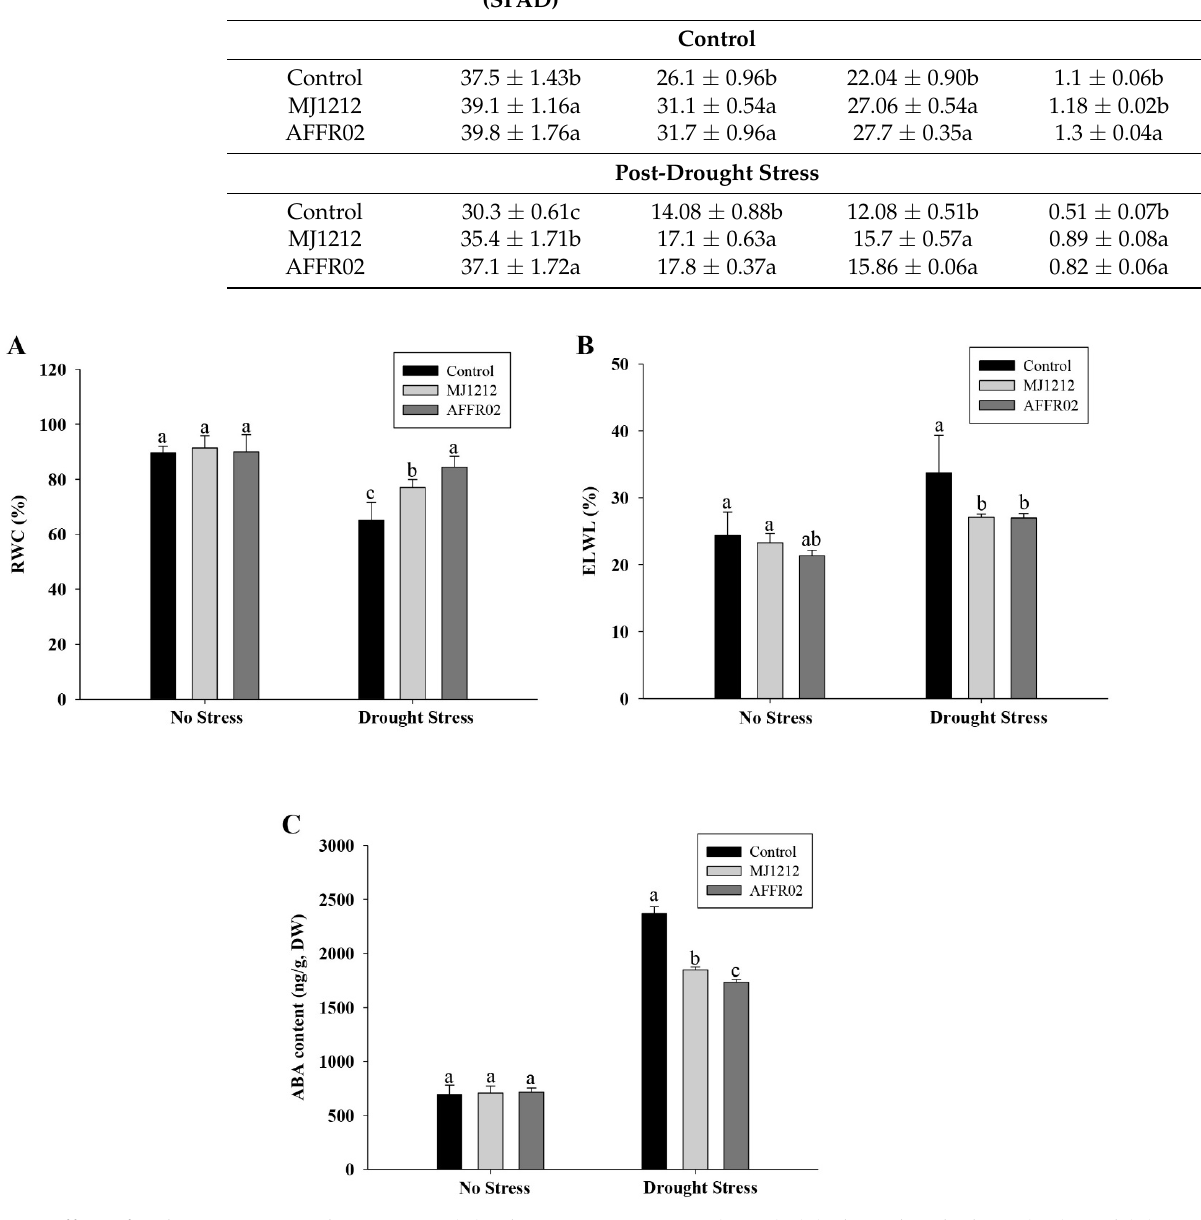
Figure 4. Effect of isolate AFFR02 and MJ1212 on ( A ) relative water content (RWC), ( B ) electrolyte leakage (EC), and ( C ) abscisic acid content (ABA) of alfalfa plants under normal and post-drought stress. The values given are the mean of three replicates and error bars indicate the standard deviation. The bars presented with different letters are significantly different from each other by using Duncan’s multiple range test at p > 0.05.